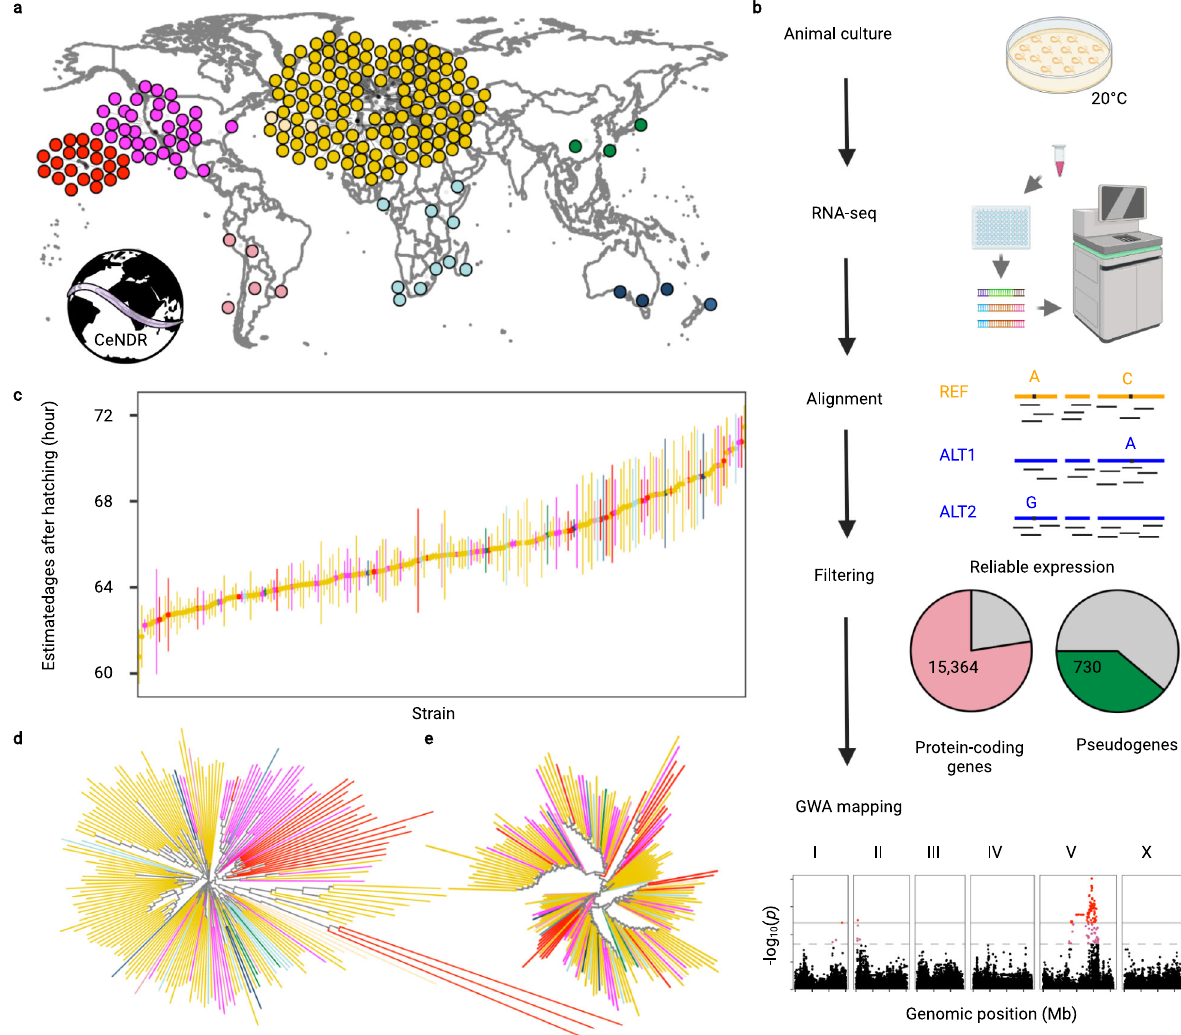
Fig. 1 Overview of species-wide expression analysis in wild C. elegans . a Global distribution of 205 of the 207 wild C. elegans strains that were obtained from CeNDR and used in this study. Strains are colored by their sampling location continent (yellow, Europe; magenta, North America; pink, South America; light blue, Africa; dark blue, Australia; green, Asia), except for Hawaiian strains (red). The two strains missing on the map are lacking sampling locations. b Graphic illustration of the work fl ow to acquire C. elegans transcriptome data. Created using BioRender.com. c Estimated developmental age ( y -axis) of 207 wild C. elegans strains (x-axis), of which 147 strains had three replicates and 60 strains had two replicates. Strains on the x -axis are sorted by their mean estimated age from two to three biological replicates. Error bars show the standard deviation of estimated age among replicates of each strain. d , e Two neighbor-joining trees of the 207 C. elegans strains using 598,408 biallelic segregating sites in non-divergent regions ( d ) and expression of 22,268 transcripts in non-divergent regions ( e ) are shown. Strains in c – e are colored as in a . 1.18, p value: 0.001) and underrepresentation of essential genes We performed marker-based GWA mappings to investigate the (Fisher ’ s exact test, odds ratio: 0.75, p value: 0.001), suggesting genetic basis of expression variation in the 25,849 transcripts (Supplementary Data 1). We determined the 5% false discovery rate (FDR) signi fi cance threshold for eQTL detection by mapping 40,000 permuted transcript expression traits using the EMMA algorithm 32 and the eigen-decomposition signi fi cance (EIGEN) threshold 33 (see “ Methods ” ). In total, we detected 6545 signi fi cant eQTL associated with variation in expression of 5291 transcripts from 4520 genes (Fig. 2b and Supplementary Data 2). In close agreement with previous C. elegans eQTL studies using recombi- nant inbred advanced intercross lines (RIAILs) derived from a cross of the N2 and CB4856 strains 3,9 , eQTL in this study were mostly found on chromosome arms (61%) relative to centers (33%), which is likely related to the genomic distribution of variation (Table 1). Of the 4520 genes with transcript-level eQTL, we found over- We classi fi ed eQTL located within a two-megabase region representation of nonessential genes (Fisher ’ s exact test, odds ratio: surrounding each transcript ( + / – 1 Mb from the transcription NATURE COMMUNICATIONS| (2022) 13:3462 |https://doi.org/10.1038/s41467-022-31208-4|www.nature.com/naturecommunications